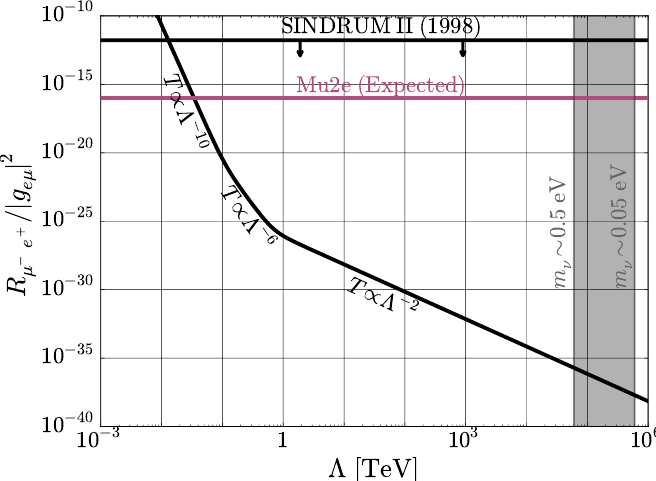
Figure 2. The estimation of the µ − → e + rate, as a function of the new physics scale parameter Λ , taken from Ref.